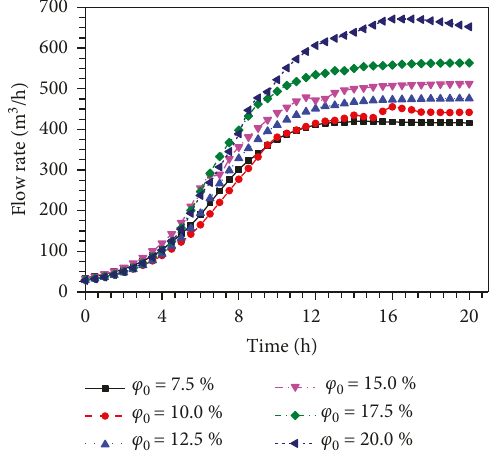
Figure 14: E ff ect of initial e ff ective porosity on fl ow rate.